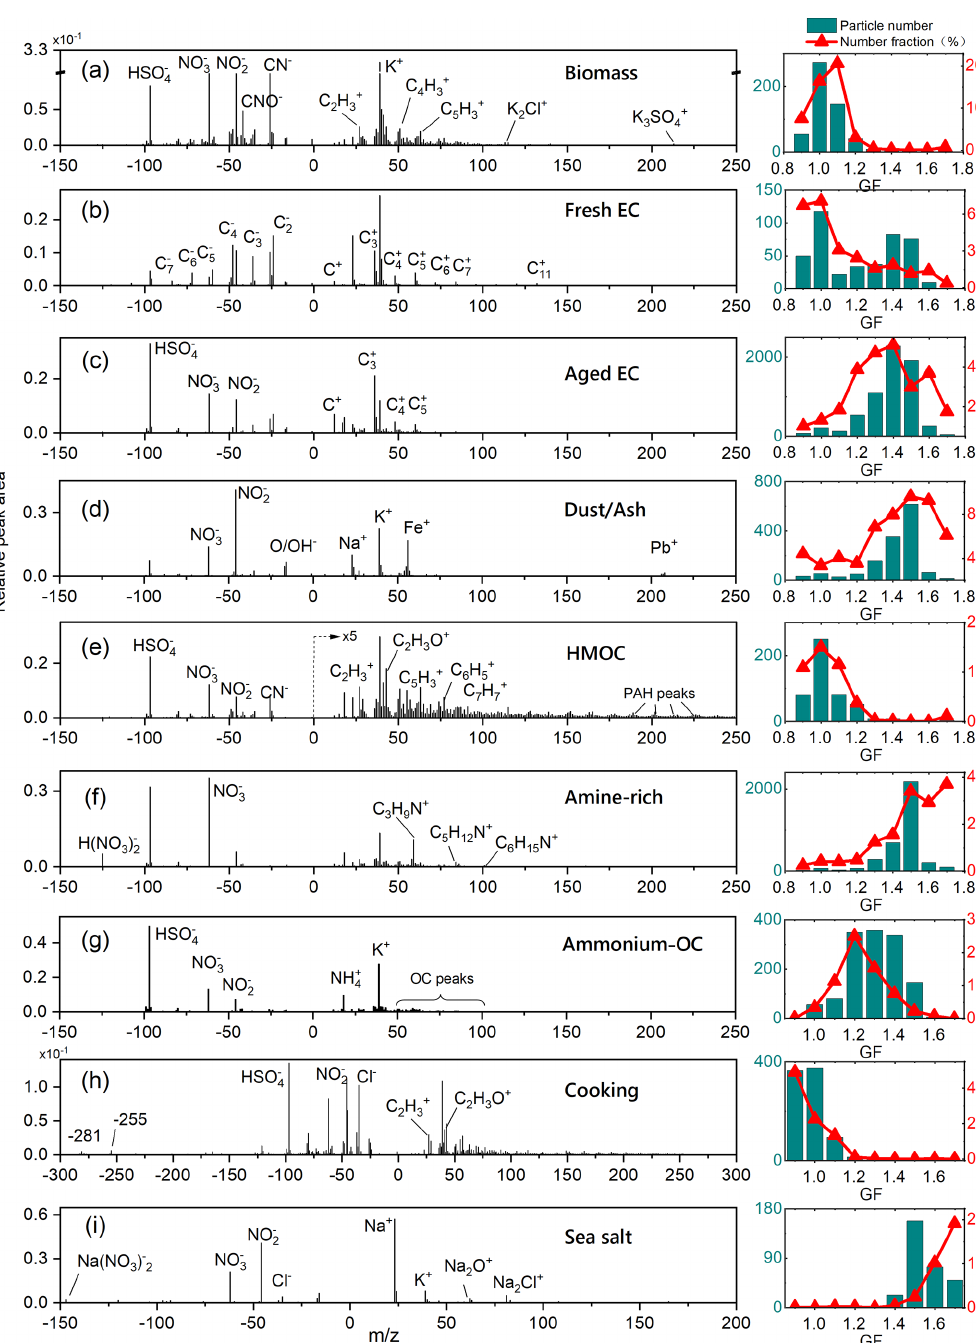
Figure 2. (Left panel) Averaged particle mass spectra of the major particle types detected in HTDMA–ATOFMS characterization. Peaks of significance were labeled. Right panels show the particle numbers of each type (left axis) and their relative number fractions in total particles (right axis) as a function of